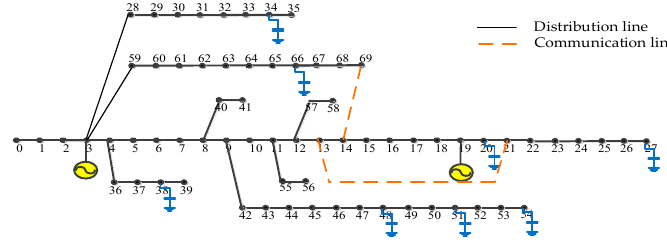
Figure 6. Modified communication topology for the revised IEEE 69-bus test system under Scenario B.